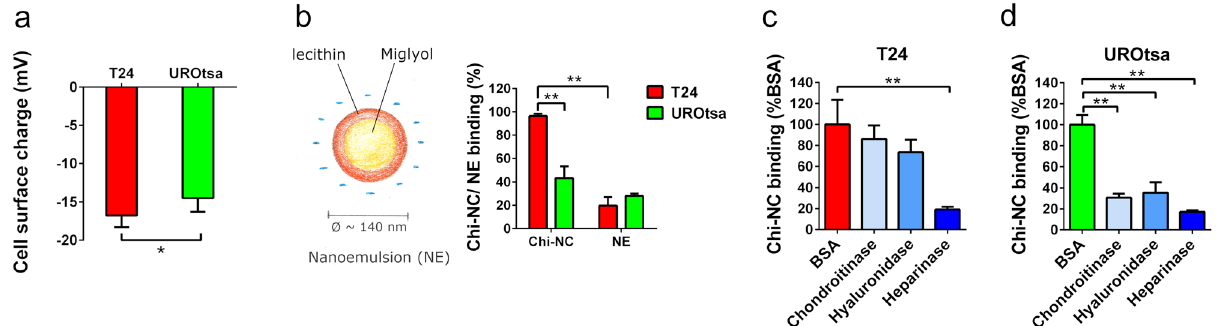
Figure 6. Electrostatic properties of urothelial cells. ( a ) Cell surface charge measurements of T24 and UROtsa cells. Data are presented as mean ± SD ( n = 3, * p < 0.05). ( b ) Schematic composition of the nanoemulsion (NE) and NE-binding capacity of T24 and UROtsa cells. NE and Chi-NC concentration = 1.78 × 10 12 particles mL −1 . Data are presented as mean ± SD ( n = 3–4, ** p < 0.01) and shown in relation to the Chi-NC binding capacity . ( c , d ) Chi-NC binding of T24 ( c ) and UROtsa cells ( d ) after digestion of the cellular glycocalyx with chondroitinase, hyaluronidase or heparinase. Chi-NC concentration = 8.96 × 10 11 particles mL −1 . Bovine serum albumin (BSA) treated cells were used as controls. Data are presented as mean ± SD ( n = 3, ** p <